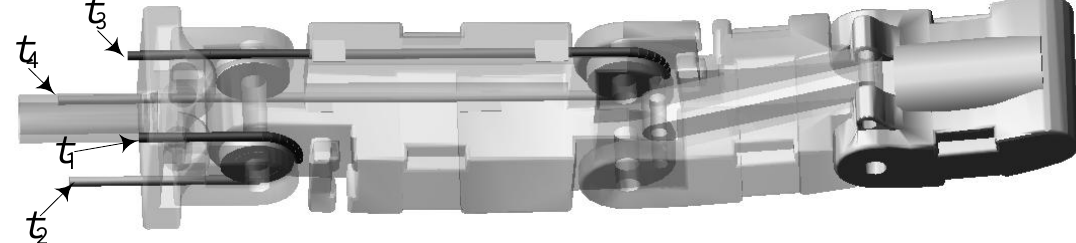
Figure 3. The tendon model in the three-DOF